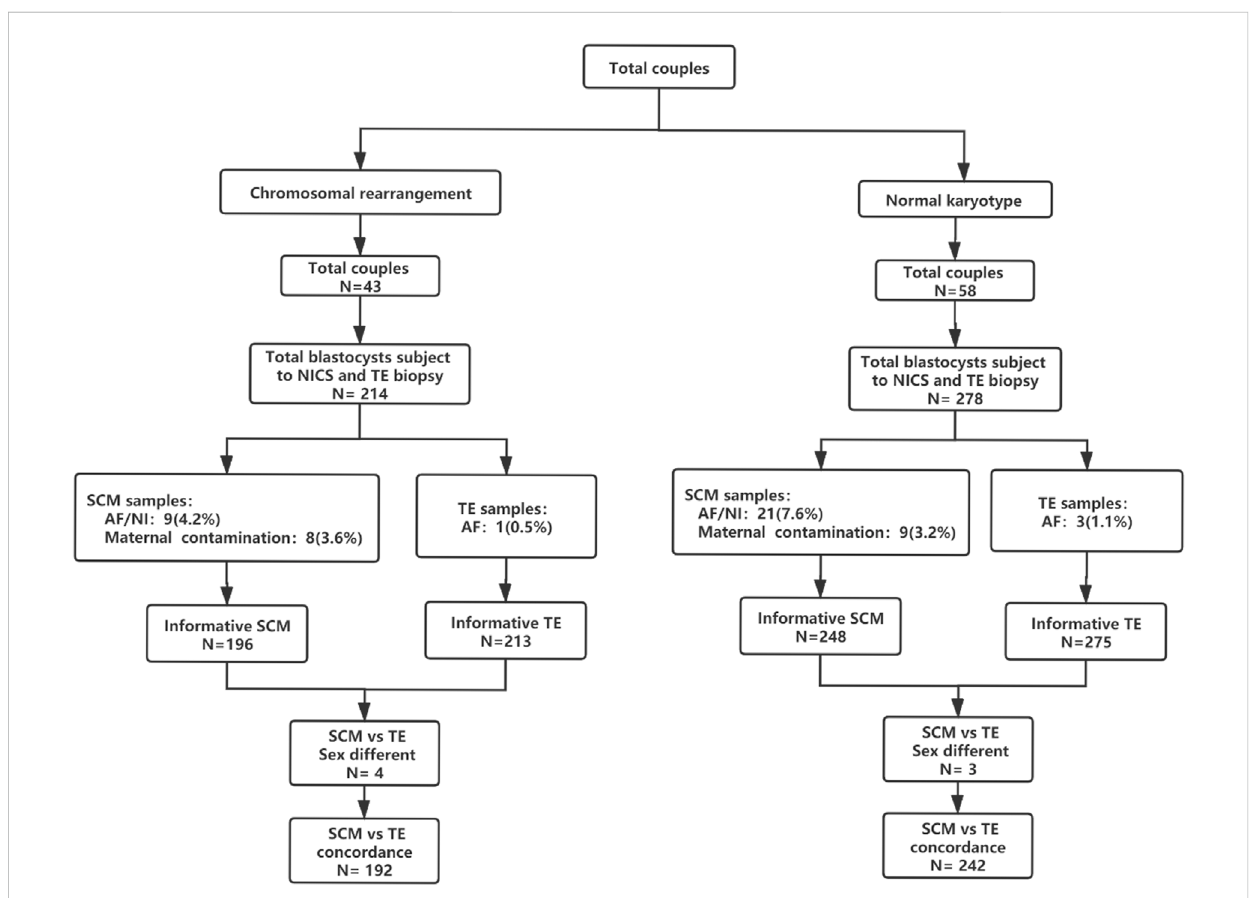
FIGURE 1 Flowchart of the study design. A total of 101 couples were included in this study; 278 blastocysts (58 couples) were included in the normal chromosome group and 214 blastocysts (43 couples) were included in the chromosomal rearrangement group. Abbreviations: AF, amplify failure; NI, non-information; NICS, non-invasive chromosomal screening; SCM, blastocyst culture fl uid; TE,